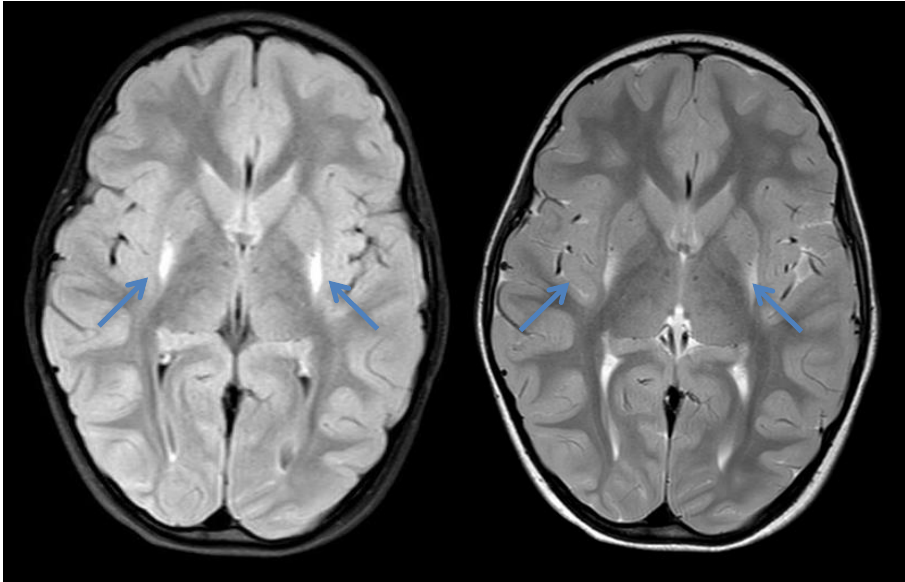
Figure 3. Cranial MRI of patient 3 at the age of 4 years showing increased signal intensity bilaterally around the putamen (blue arrows) in axial T1 and T2—the typical insidious onset pattern of